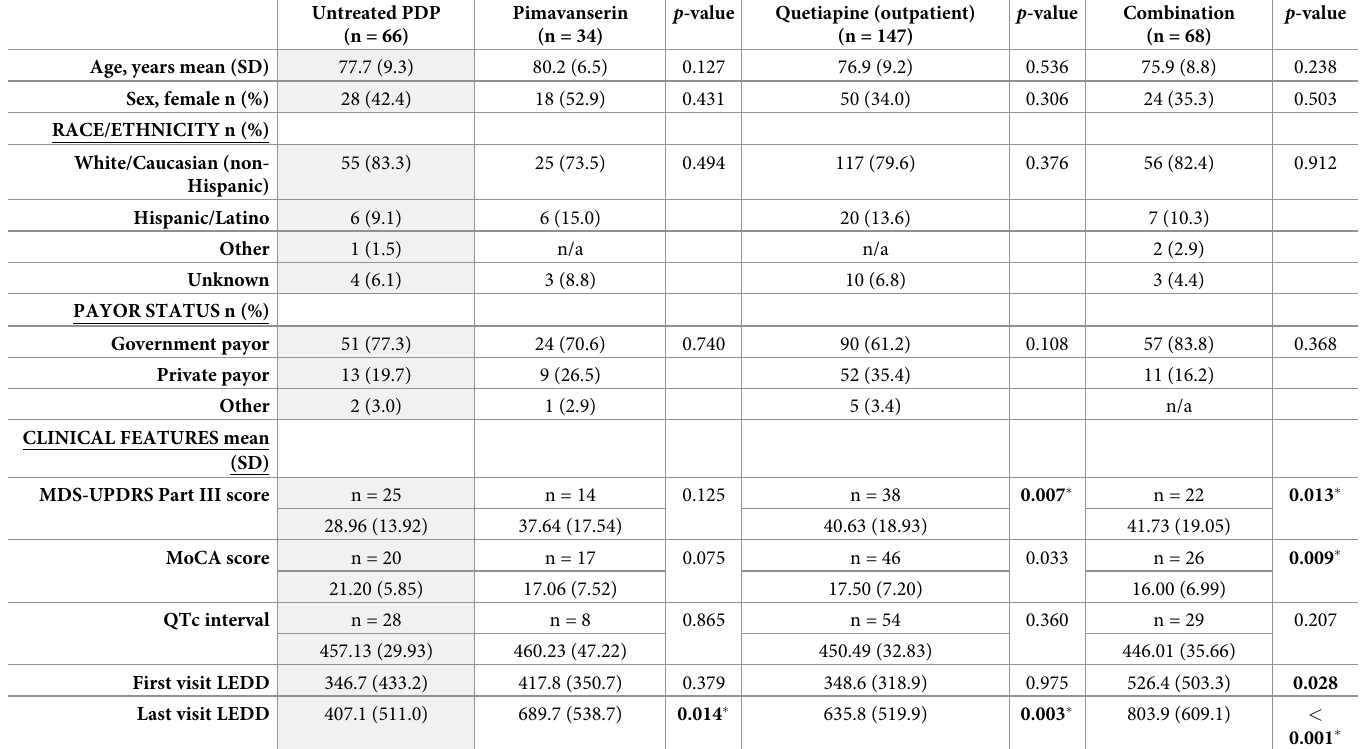
Table 1. Comparison of demographic and clinical characteristics at baseline between Parkinson disease psychosis (PDP) group not receiving antipsychotics (untreated) and PDP groups treated with pimavanserin, quetiapine, or combination pimavanserin and